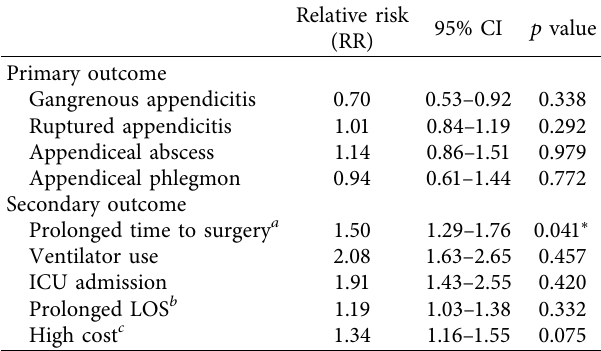
Table 4: Multivariate analyses of primary and secondary